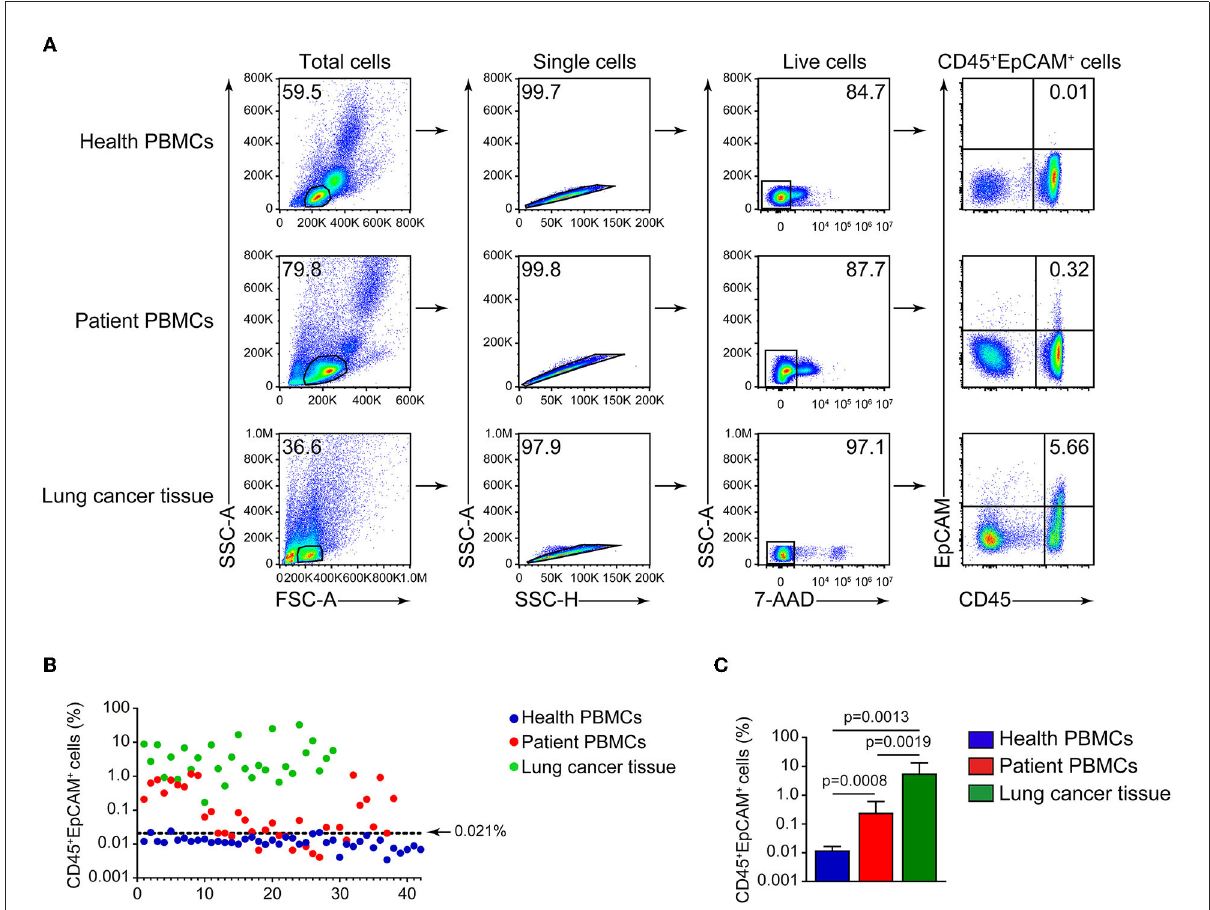
FIGURE2 Detection of CD45 + EpCAM + cells in lung cancer tumor tissues and PBMCs. (A) Representative flow cytometry plots of CD45 + EpCAM + cells proportion in PBMCs of healthy volunteers, patients’ PBMCs and lung cancer. (B) Depiction of CD45 + EpCAM + cell ratio difference in PBMCs of healthy volunteers, patients’ PBMCs and lung tumors (healthy volunteers = 42, patients = 38, lung tumors = 29). The top limit for a normal range (0.021) was determined by healthy volunteer’s mean + 2 SD. (C) Statistical plots of CD45 + EpCAM + cell ratio in PBMCs of healthy volunteers, patients’ PBMCs and lung cancer cells (healthy volunteers = 42, patients = 38, lung tumors =